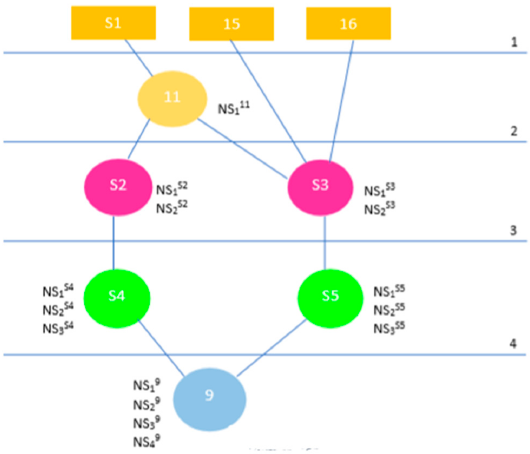
Figure 10. Disassembly geometry contacting graph ( DGCG).